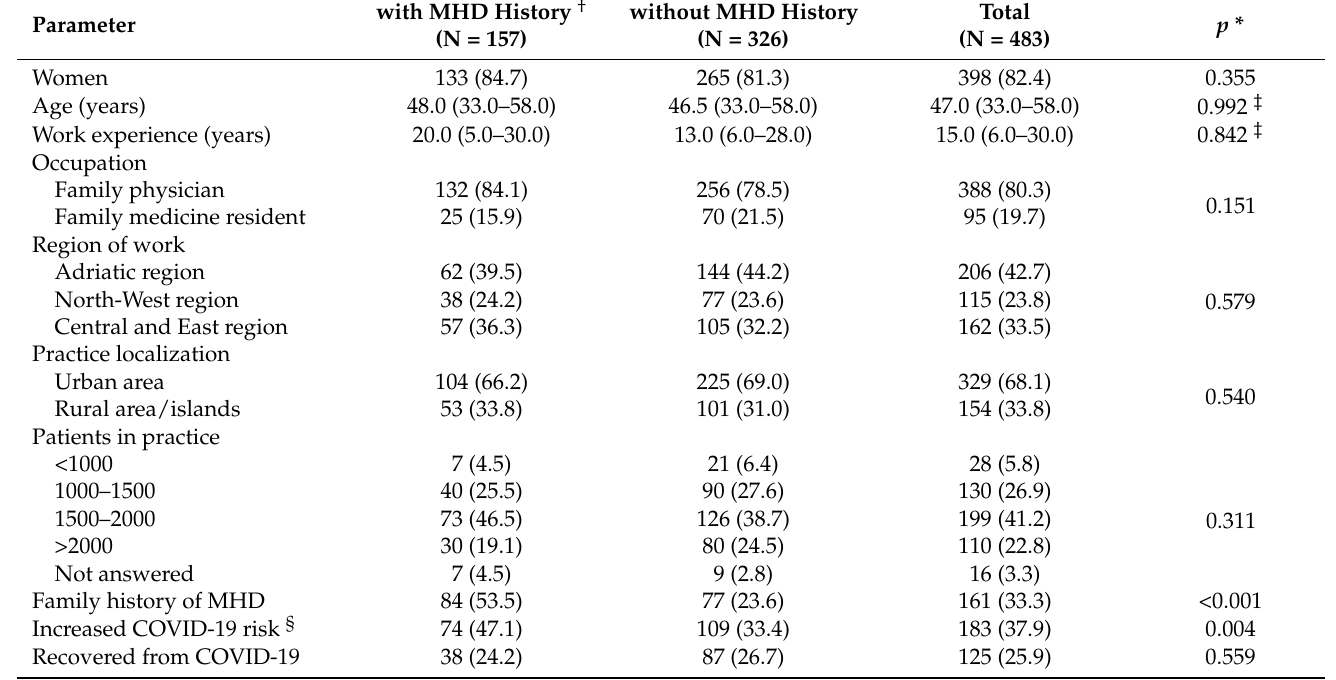
Table 1. Baseline characteristics of study population according to mental health disorder medical history.